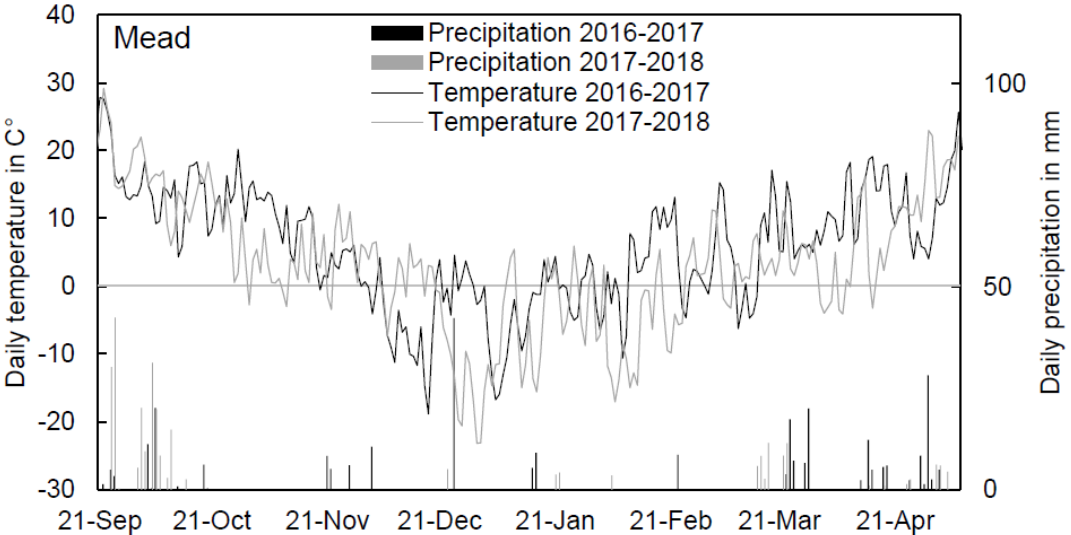
Figure 2. Daily average temperature (left axis, line graph) and precipitation (right axis, bar graph) from cover crop planting to cover crop harvest for year 1 (September 2016 to May 2017) and year 2 (September 2017 to May 2018) at Mead.